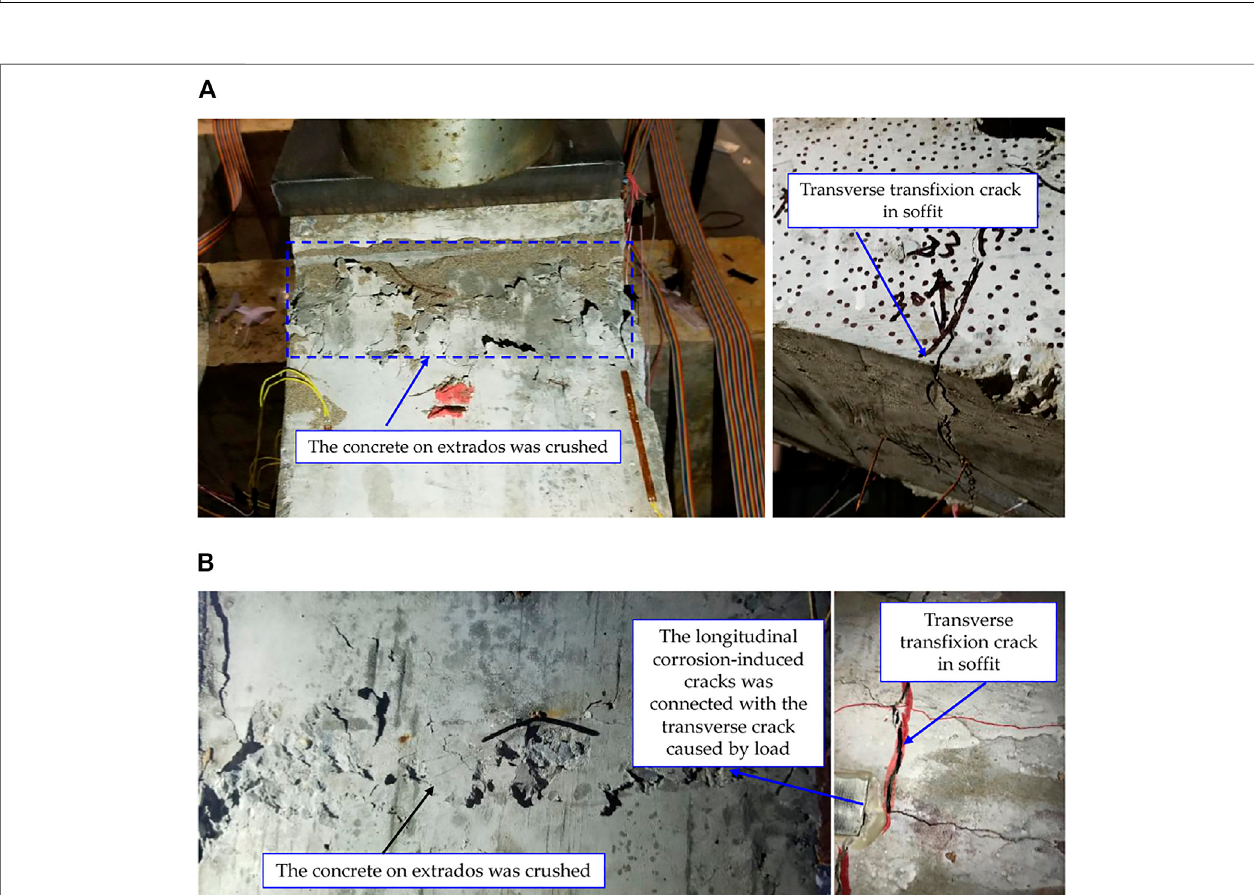
FIGURE 12 | Failure mode: (A) arch 0# and (B) arch 1#.